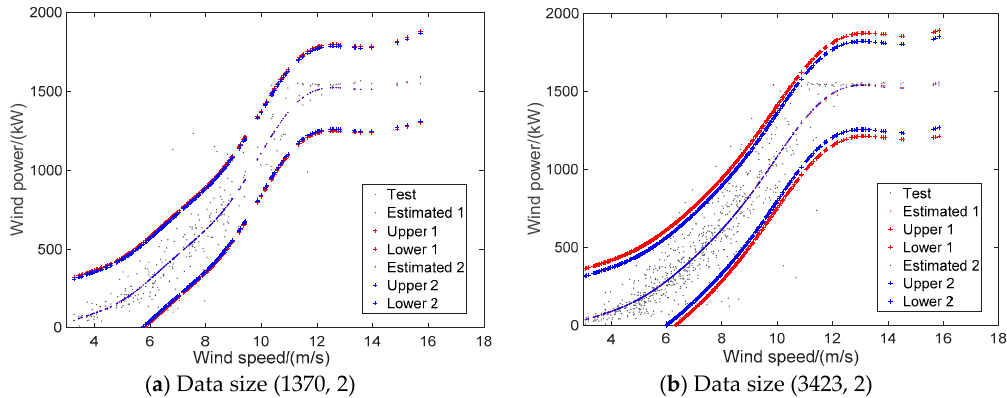
Figure 7. Comparison of WTPC models using different objectives.